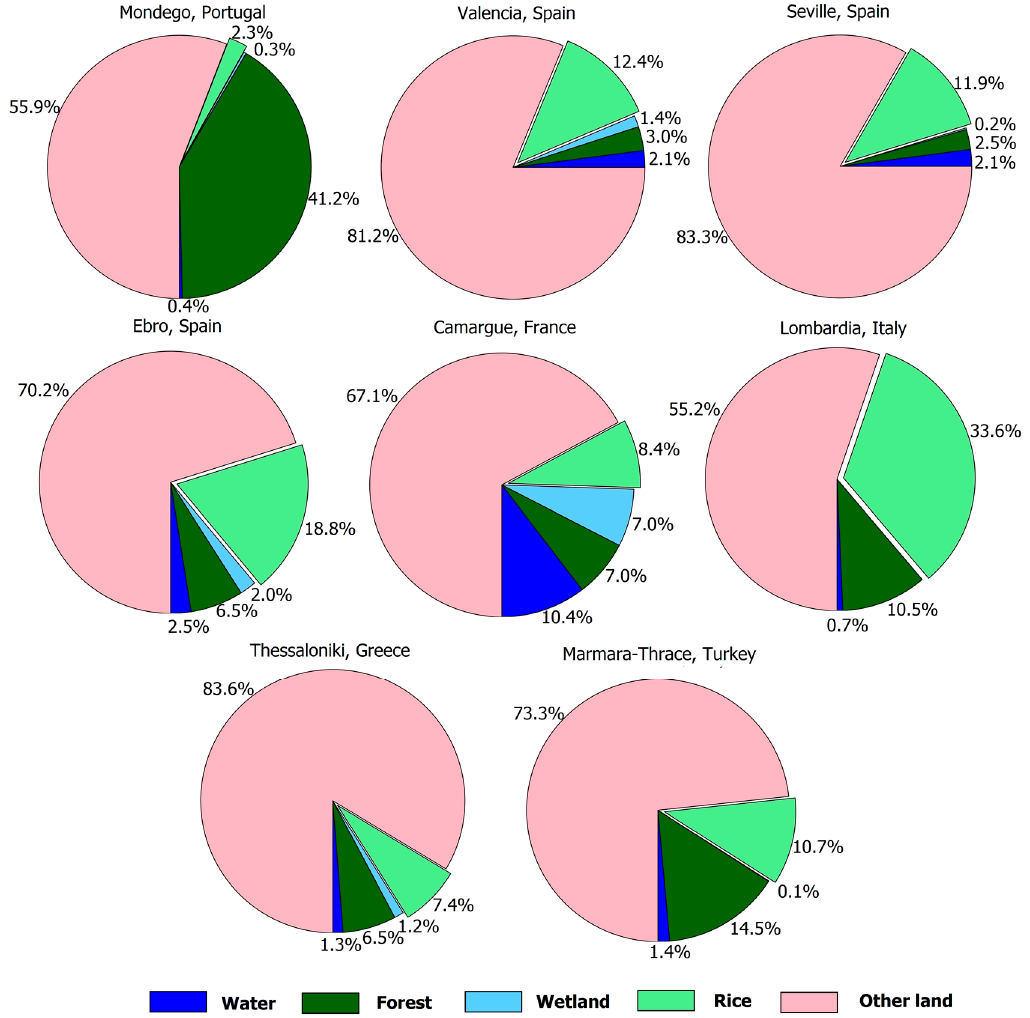
Figure 5. Relative contribution of harmonized land-cover categories in eight selected test sites.